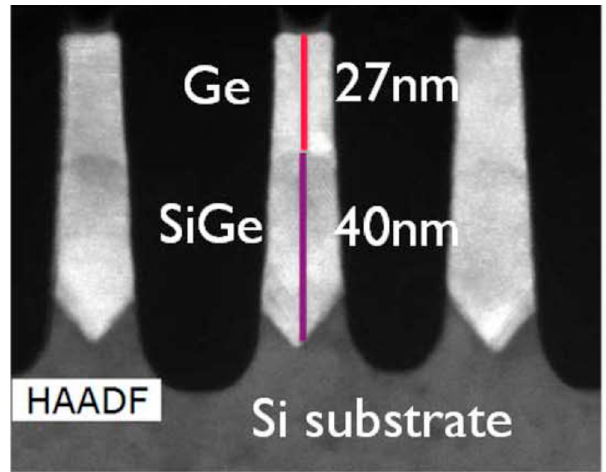
Figure 20. Cross-section TEM image of strained Ge-cap/ SRB Si 0.3 Ge 0.7 SEG grown inside oxide trenches of FinFET [110].